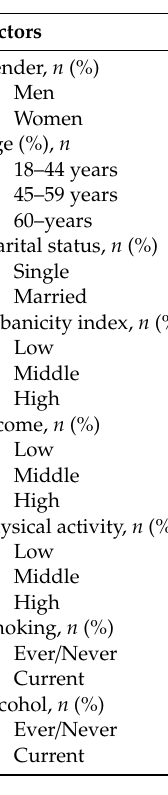
Table 1. Baseline characteristics of the study population by